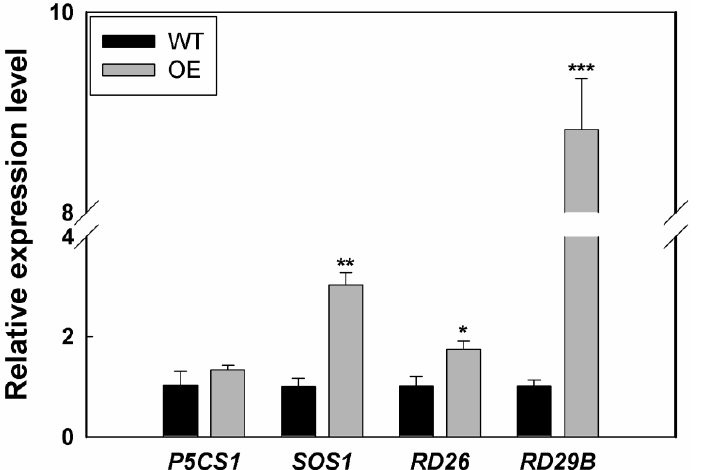
Figure 8. Relative expression levels of five stress-associated genes in the LcSAIN3 -overexpressing plants compared with wild-type under salt stress. Real-time PCR analysis of six salt-stress-induced genes in transgenic Arabidopsis plants in the presence of 150 mM NaCl. AtActin2 was used as the reference gene. ***, **, and * indicate significant differences in comparison with the control at p < 0.001, p < 0.01, and p < 0.05, respectively.